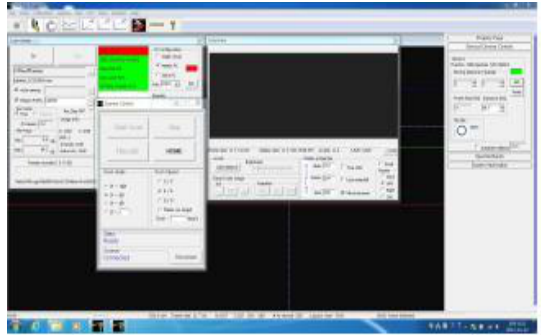
Figure 7. The full screen of VNIR program